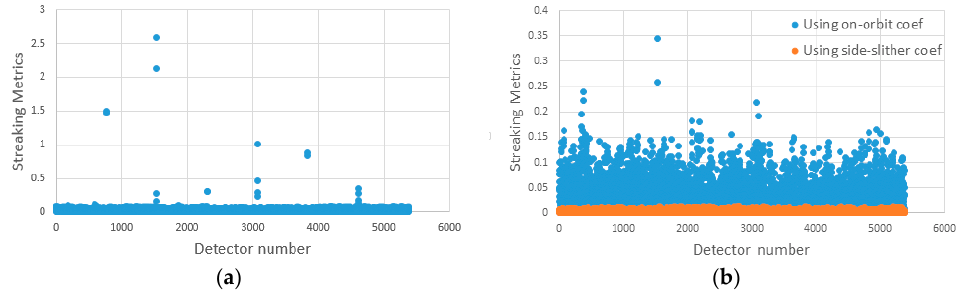
Figure 9. Streaking metrics analysis of the standard image and corrected images. ( a ) The streaking metrics of the standard image; ( b ) The streaking metrics of the images corrected using the on-orbit coefficients and side-slither coefficients.